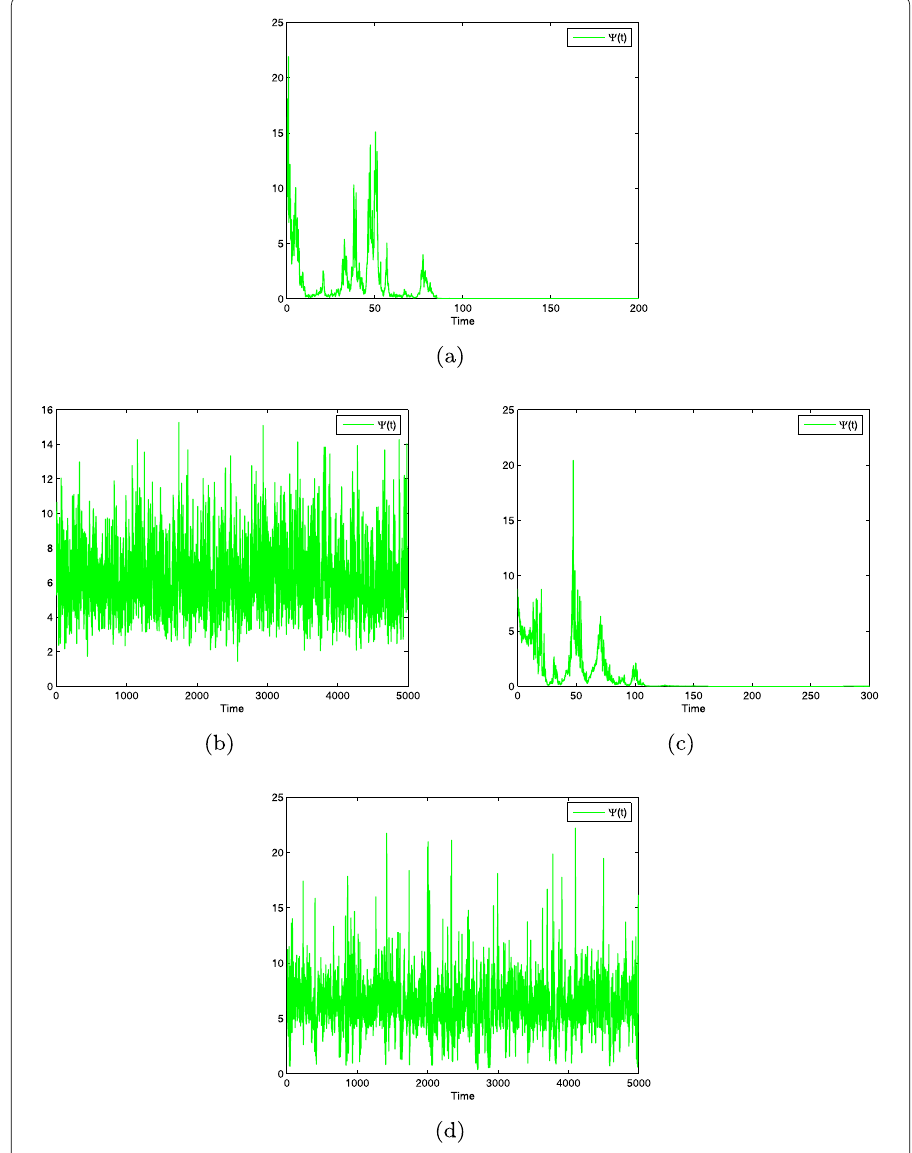
Figure 1 Paths of model (3) with Θ = { 1,2 } , r ≡ 0.15, μ ≡ 3, λ ≡ 25, η 2 1 (1) = 0.6, η 2 1 (2) = 0.2, η 2 2 ≡ 0.16. ( a ) is a path of the solution of state 1, which manifests that the extinction happens in about 85 years. ( b ) is a path of the solution of state 2, which manifests that the species is SP. ( c ) is a path of the solution of model (3) with σ = (0.8,0.2), which manifests that the extinction happens in about 105 years. ( d ) is a path of the solution of model (3) with σ =